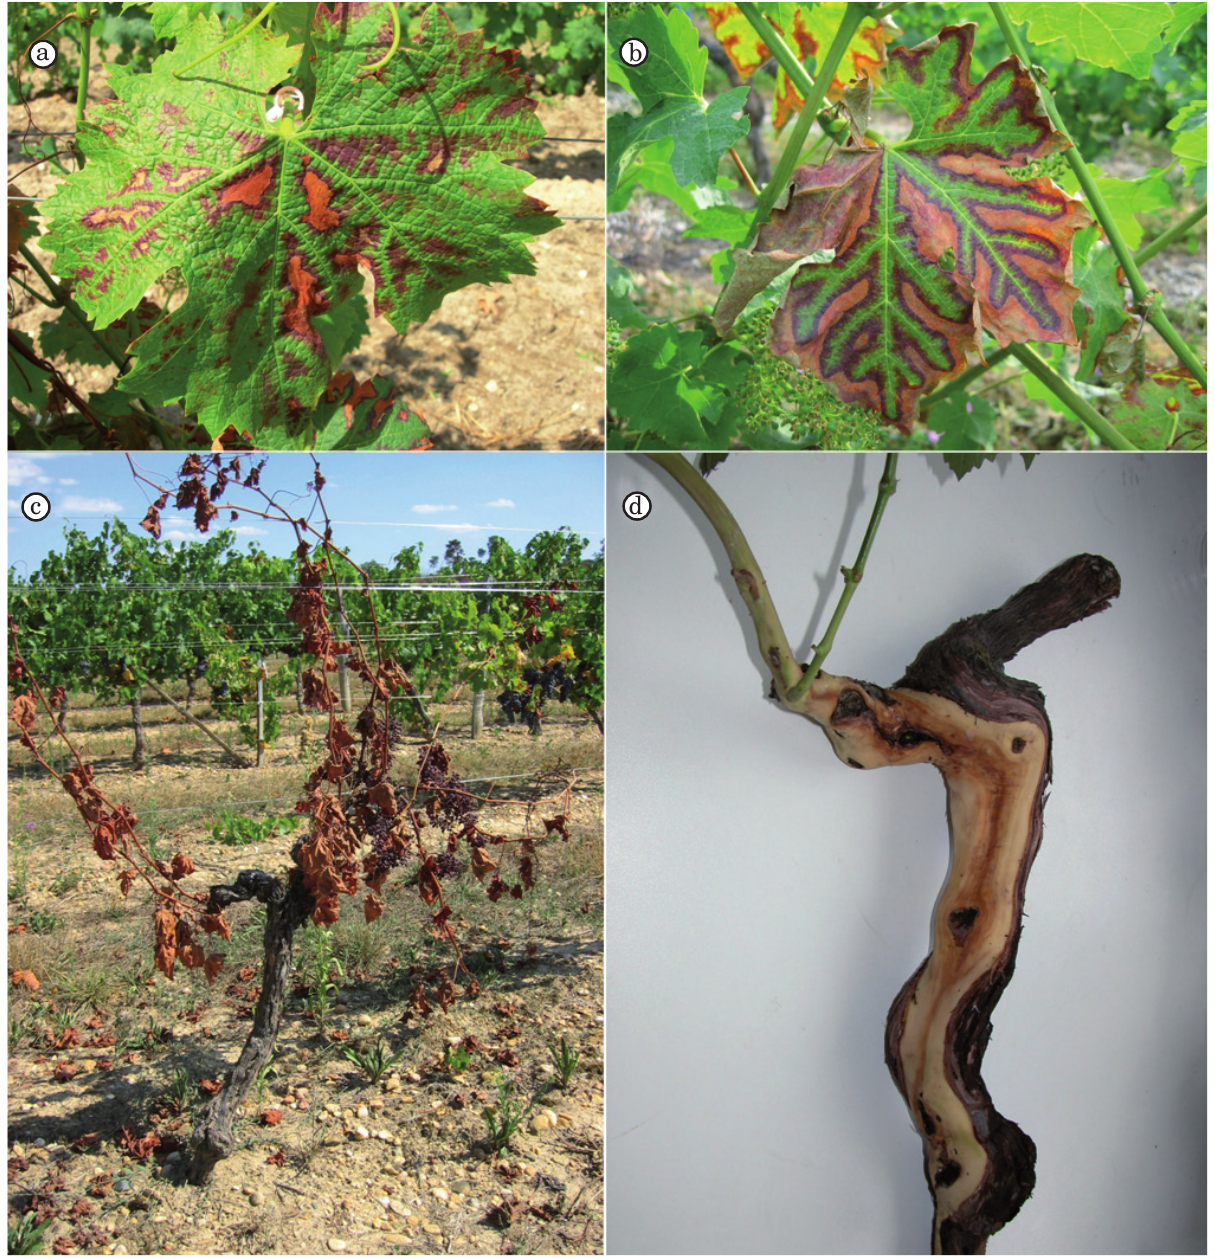
Figure 2. Symptoms attributed to black dead arm by Larignon and Dubos (2001) and Larignon et al ., (2001). a–b. Symptoms on the leaves are dark-red patches that extend causing eventual dry out of the tissues between the veins and the margin of the leaf. c. Severe form of the disease causing a quick dry out and fall of the leaves in the entire vine. d. Light-brown streak under the bark extending from spur position. Based on studies conducted by Lecomte et al ., (2005) and Surico et al ., (2006), it is currently well accepted that these symptoms correspond with esca disease of grapevines and not with Black dead arm. (Pictures courtesy of P. Lecomte, UMR Santé Végétale INRA-ENITAB, Villenave d’Ornon,